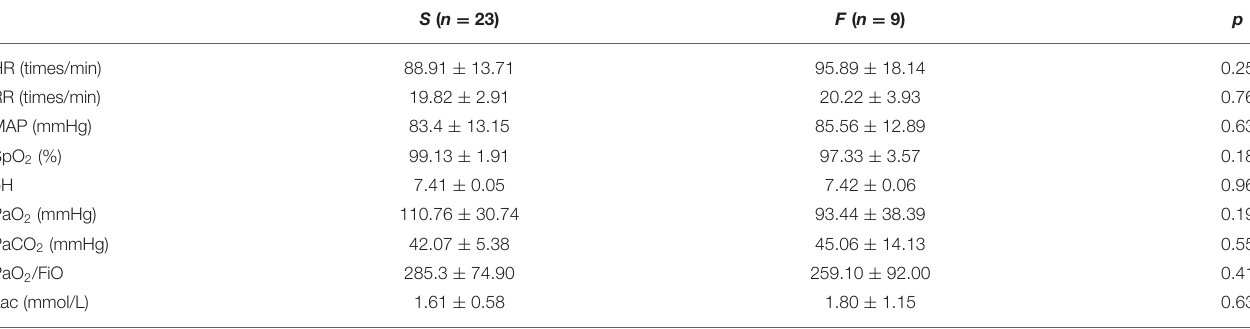
TABLE 2 | Patient’s characteristics and arterial blood gases in patients at the end of SBT.